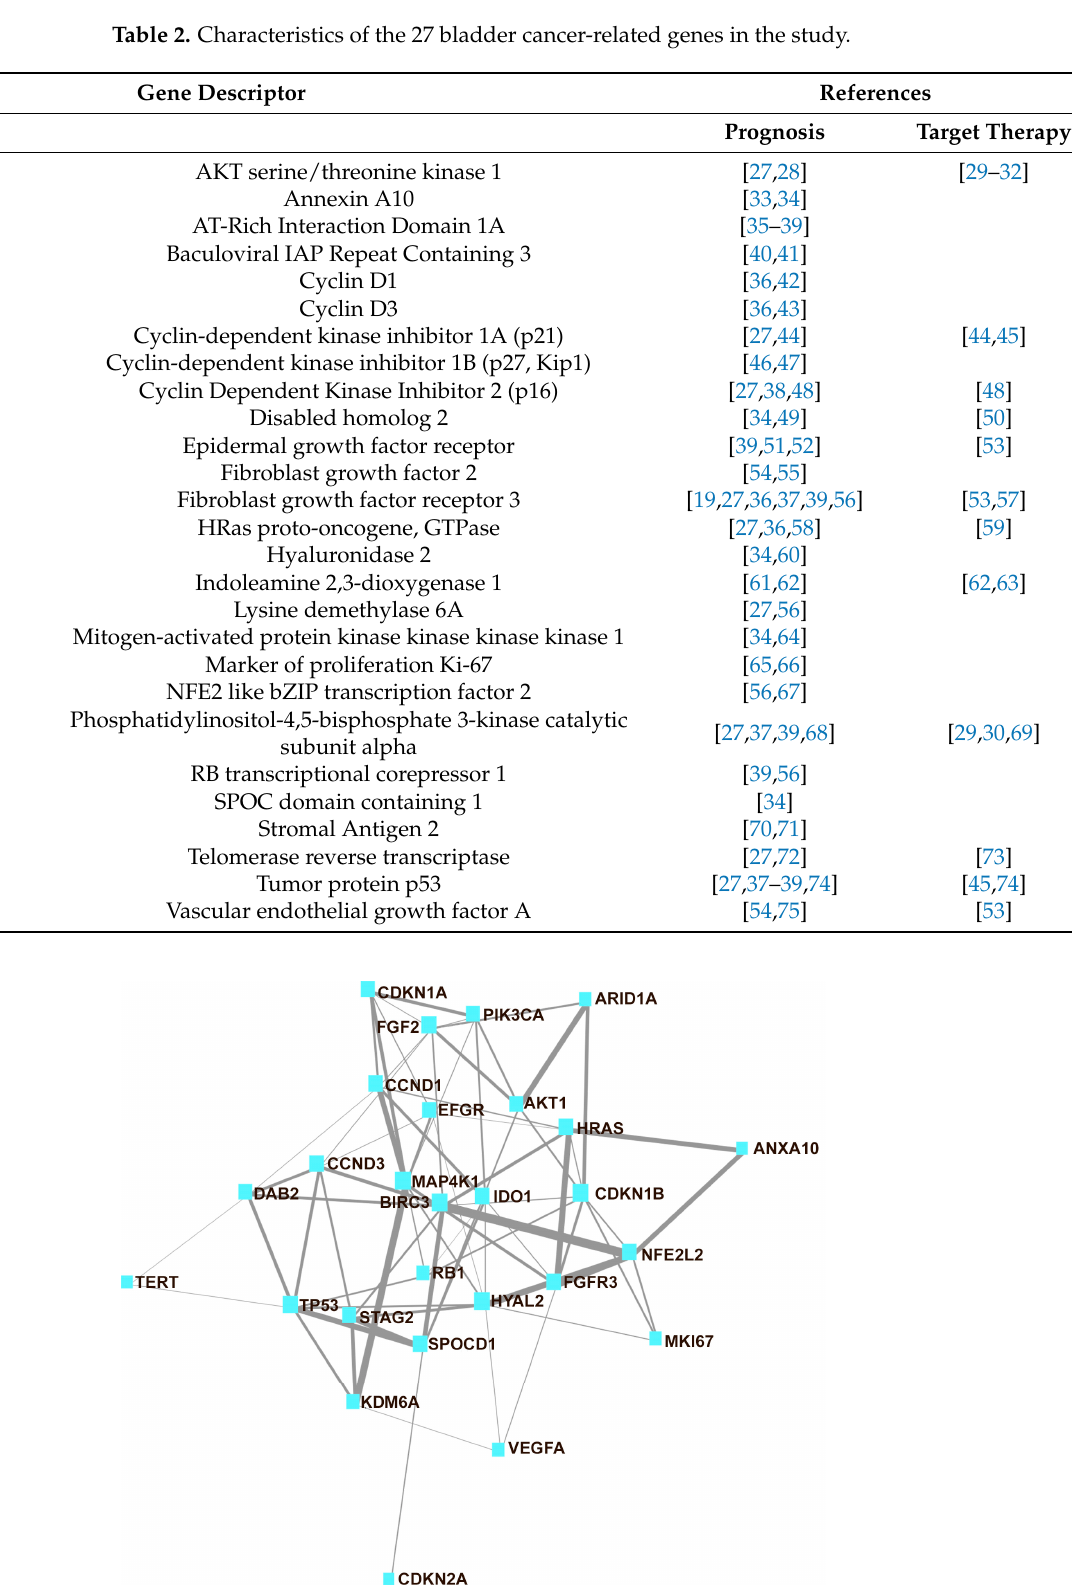
Figure 1. Network map of the 27 interconnected genes assayed in the current study. The thickness of the line is related to the strength of the association between genes (network analysis obtained using MetaboAnalyst version 5.0).